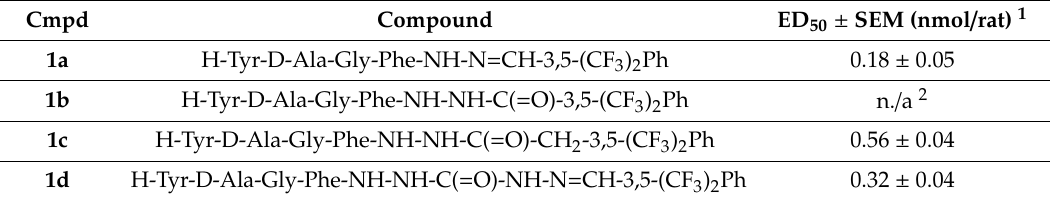
Figure 8. Comparison of the area under the time course curve (AUC) with a 0.5 nmol/rat dose for compounds 1a – 1d . Results were analyzed with one-way ANOVA followed by the Tukey post-hoc test. Asterisks (*) indicate a significant difference on comparison of particular pair of columns. Note: * p < 0.033, and ** p < 0.002. Table 3. The effective dose (ED 50 ) of compounds 1a – 1d .